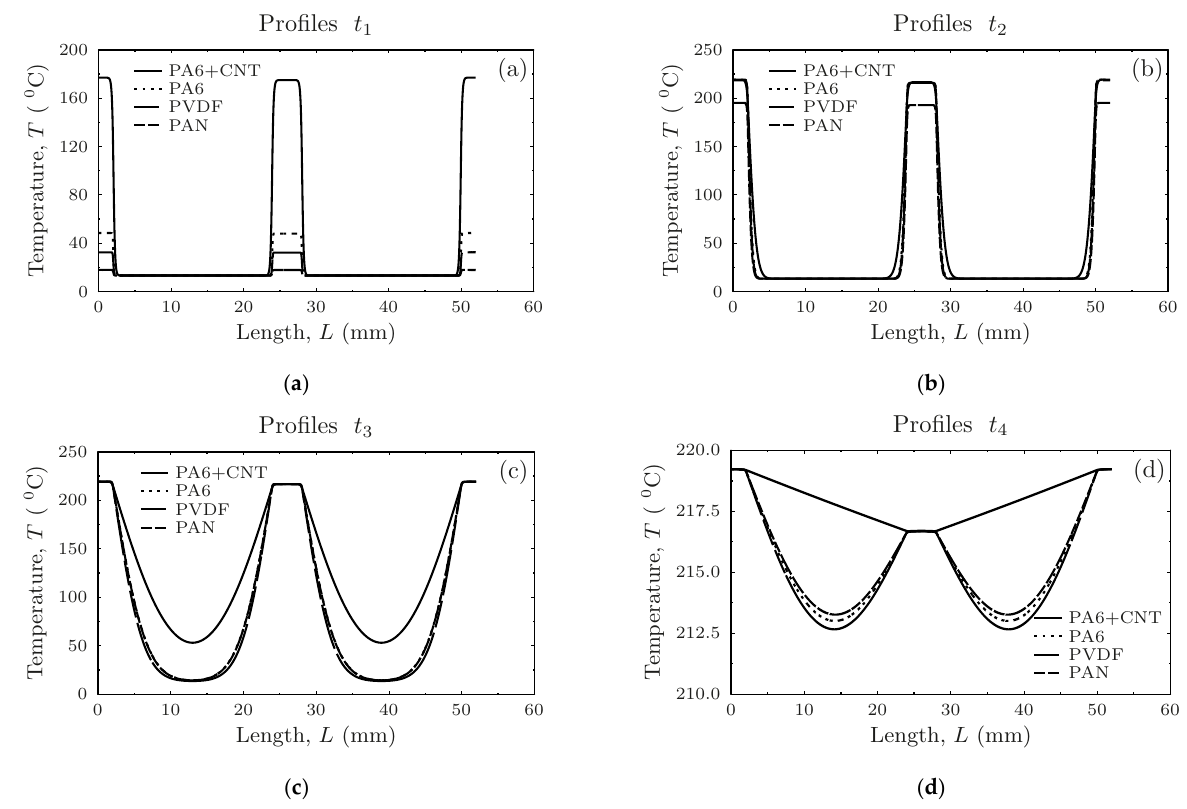
Figure 9. Temperature profiles for all materials at ( a ) 1 × 10 − 4 s., ( b ) 2 × 10 − 3 s., ( c ) 9 × 10 − 2 s., ( d ) 3